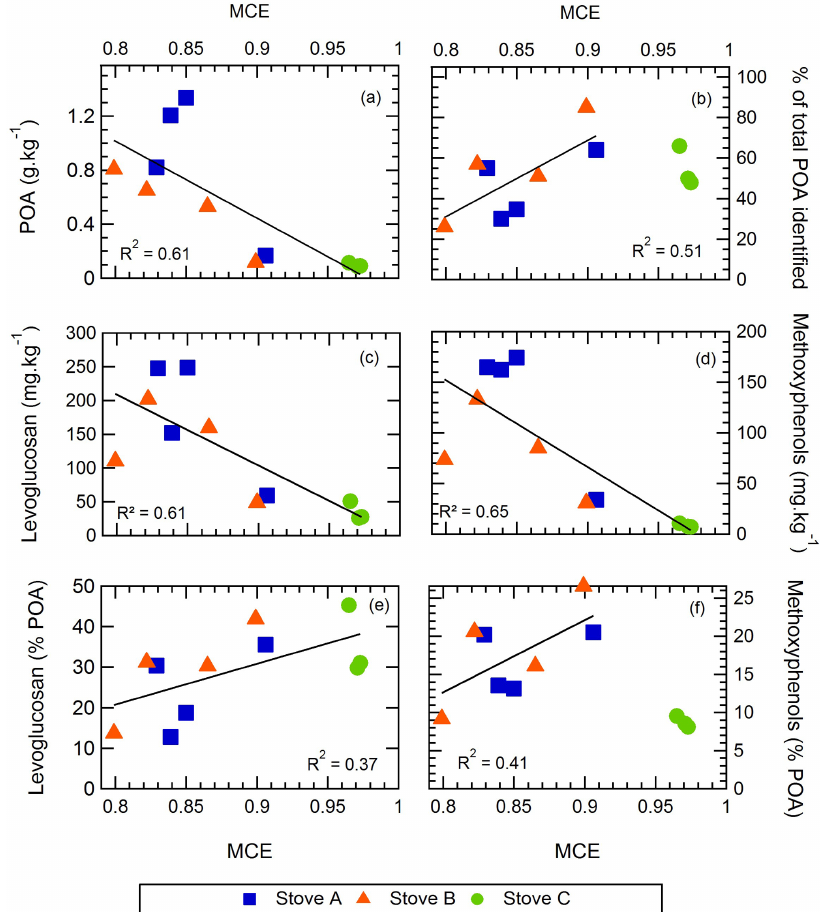
Figure 4. Emissions factors of POA, levoglucosan, and methoxyphenols, as well as their contribution to the total OA as a function of the modified combustion efficiency (MCE). Details on how the MCE was calculated are given in Bertrand et al.